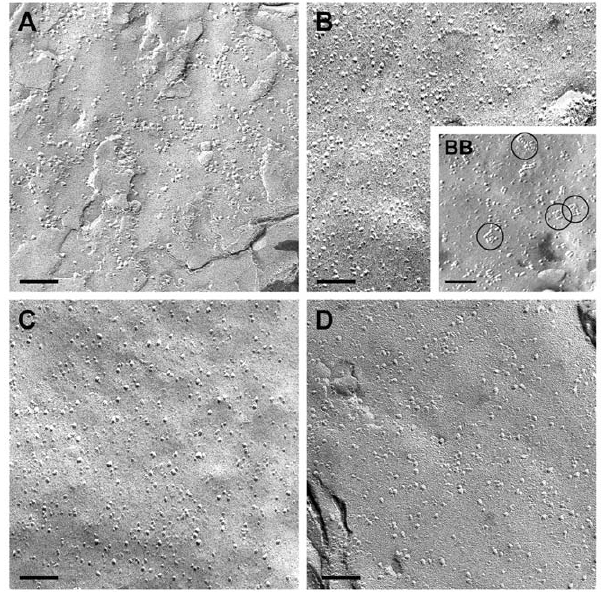
Figure 6. Freeze fracture analysis of the C6 system. (A) C6 implanted intracerebral tumor, (B), C6 cell culture. C6 cells implanted extracranial (C) and flank tumor (D). There are no OAPs. In contrast (BB) shows a freeze fracture replica of primary astrocytes in culture revealing a few OAPs (encircled). Scale bars 100 nm.